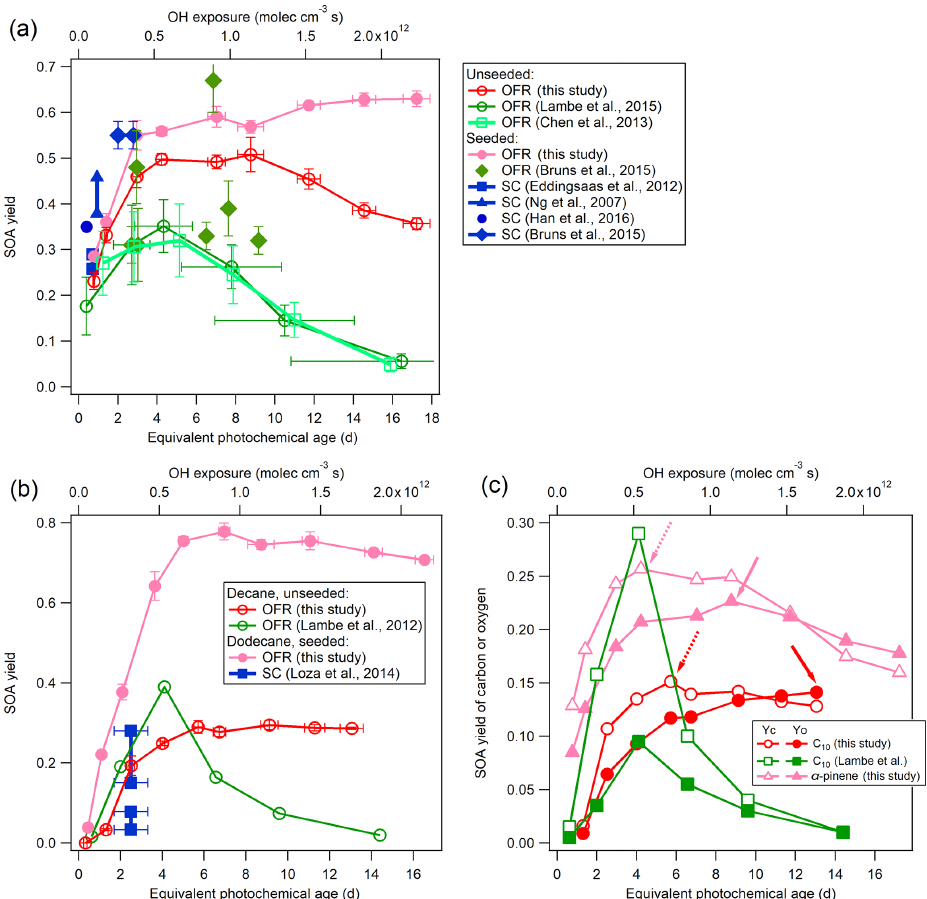
Figure 3. Low-NO x SOA yields of α -pinene (a) , n -decane (C 10 ), and n -dodecane (C 12 ) (b) compared to previous studies using OFRs and smog chambers (SCs; Ng et al., 2007;Eddingsaas et al., 2012; Lambe et al., 2012, 2015; Chen et al., 2013; Loza et al., 2014; Bruns et al., 2015; Han et al., 2016). The details regarding these comparisons are shown in Table 2. (c) SOA carbon and oxygen yields ( Y C and Y O ) for single precursors for unseeded experiments in the current study and in a previous study (Lambe et al., 2012). Dashed and solid arrows indicate the maximum of Y C and Y O ,